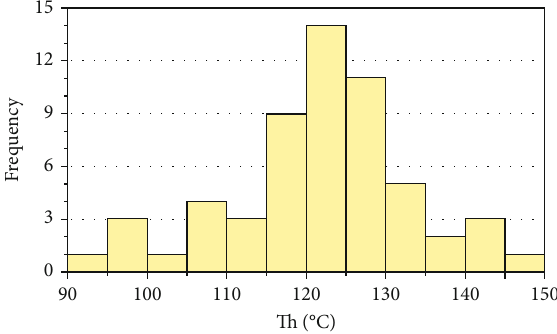
Figure 9: Histogram of homogenization temperatures (Th) from all primary fl uid inclusions from the late ankerite cements in the Es sandstones ( n = 57